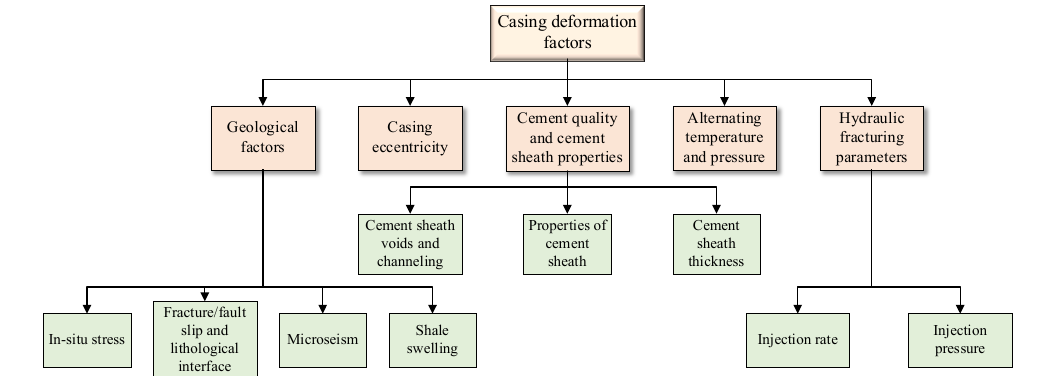
Figure 12. The relationship between the influencing factors.